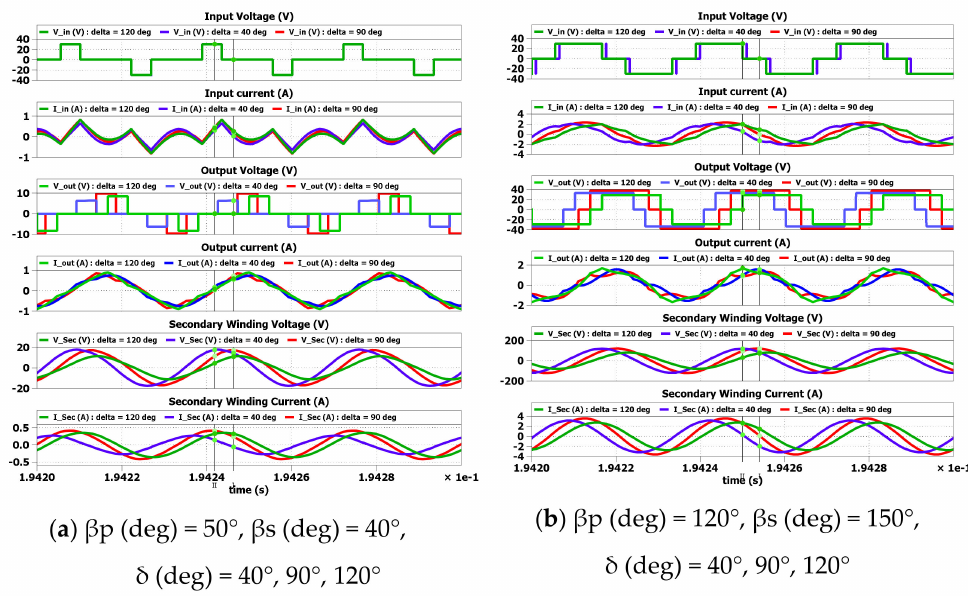
Figure 14. Inverter/rectifier AC voltage/current and receiver winding voltage/current waveforms for same β p and β s and different δ